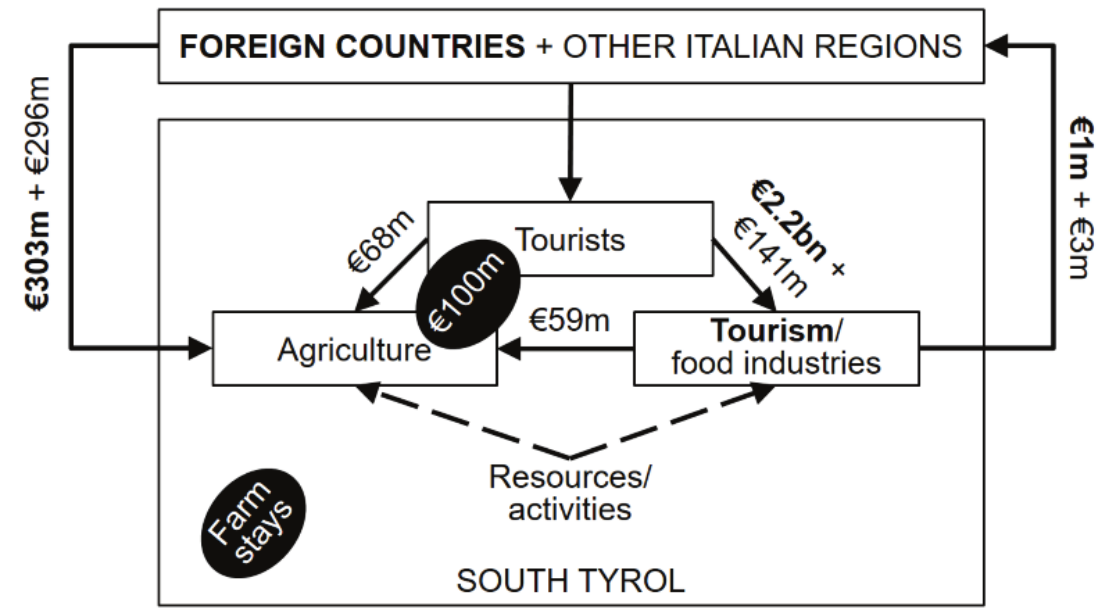
Figure 2: Summary of the farmer-revenue-from-tourism situation in South Tyrol,